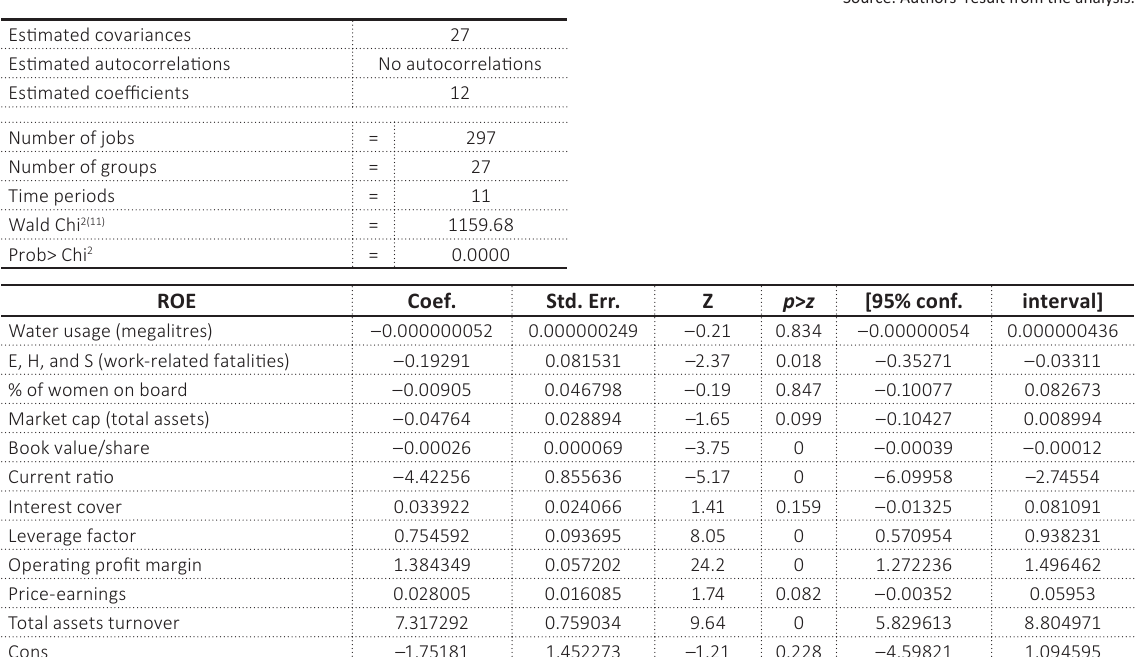
Table 2. Regression analysis